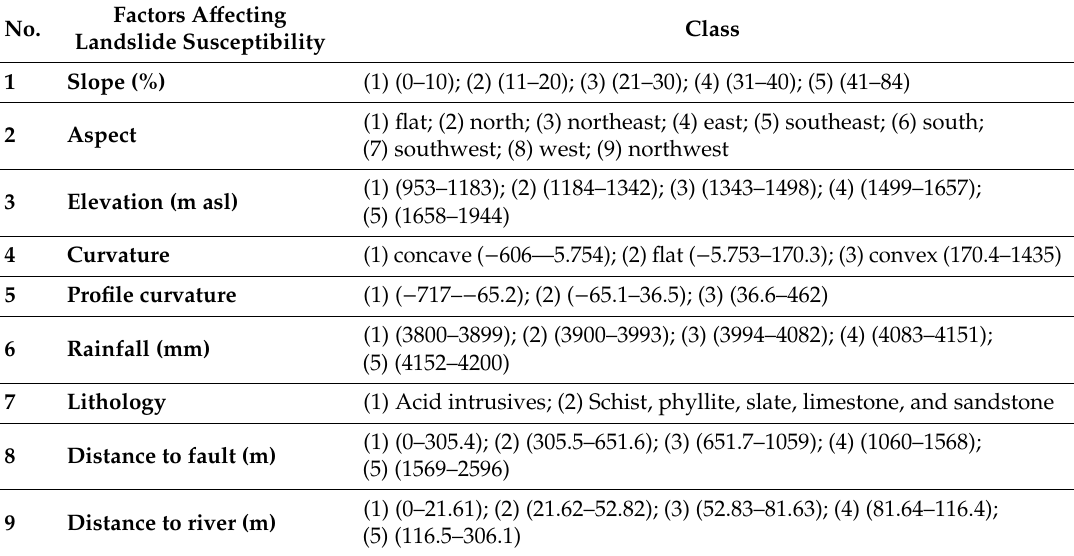
Table 3. Classes of environmental factors a ff ecting landslide